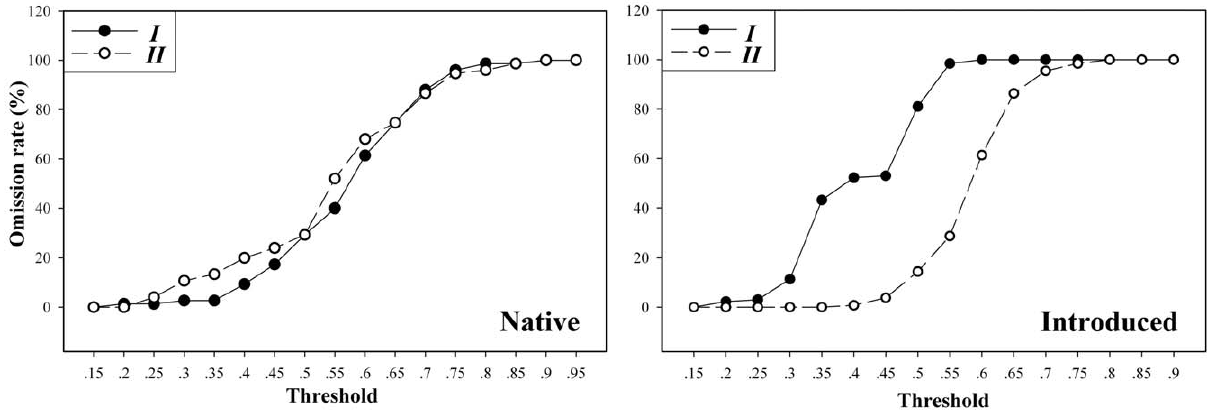
Figure 4. Omission rates among niche models based on Dataset I and II . Omission rates were plotted in native Asia models and their transferring in the US across the threshold spectrum of Maxent.